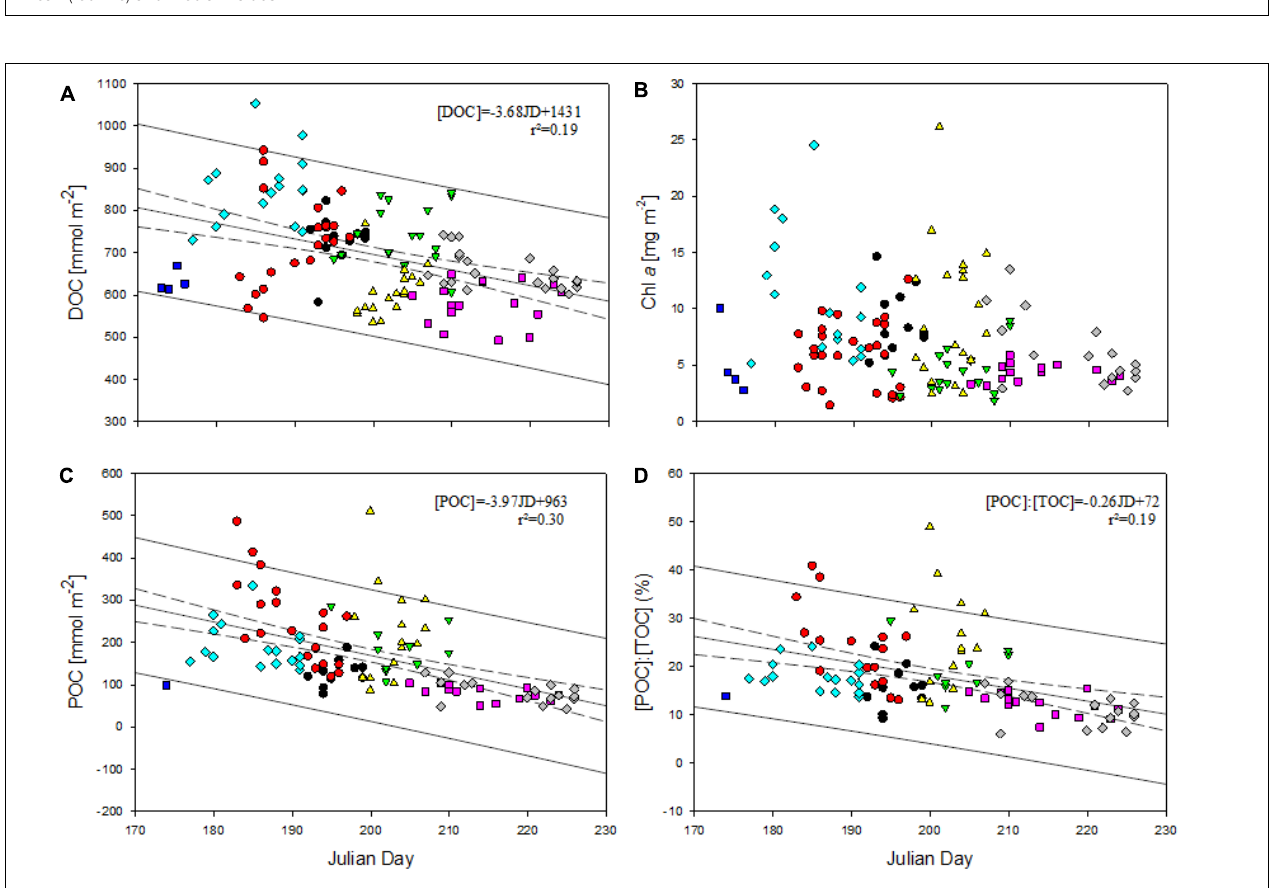
FIGURE 8 | (A–D) Relationship between integrated DOC (A) , Chl-a (B) , and POC (C) concentration and the Julian day (JD) of sampling as well as the ratio of POC to TOC (D) . Color code of years: black (2009), red (2010), green (2011), yellow (2012), blue (2014), pink (2015), turquoise (2016), gray (2017). Dashed lines represent the 95% confidence interval of the regression, solid lines the 95% confidence interval of the data population.